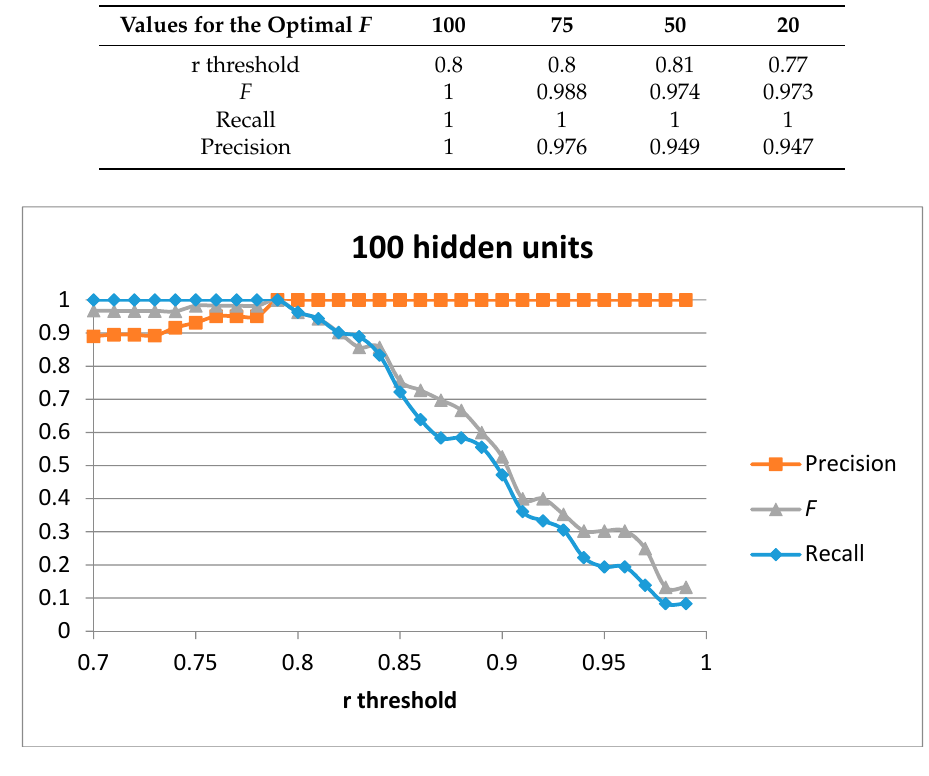
Figure 4. Precision, recall, and F score for 1 auto-encoder and 100 hidden units.